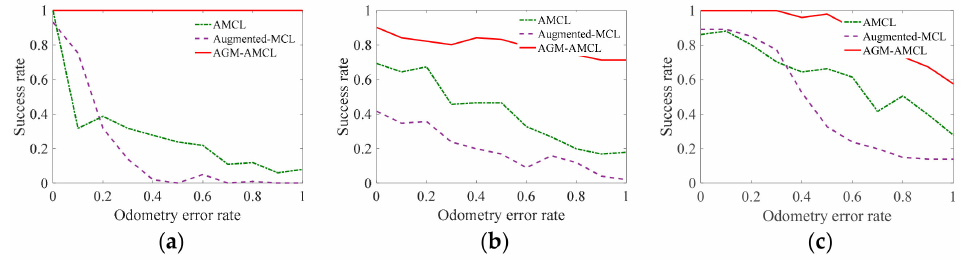
Figure 16. The success rate of three localization methods with di ff erent odometry errors: ( a ) Results in Scene A. ( b ) Results in Scene B. ( c ) Results in Scene C. The results show that our method has a